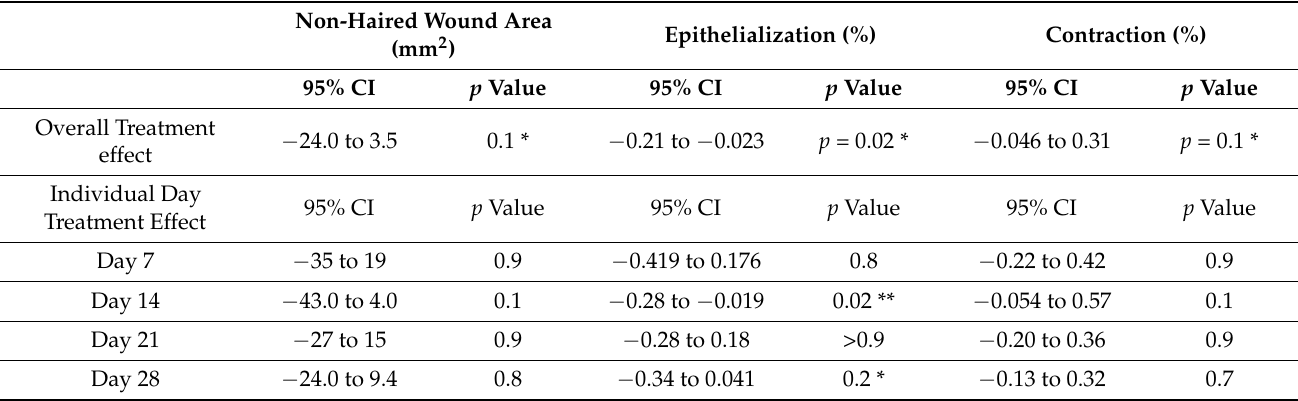
Table 3. GEE analysis of rate of limb wound closure by epithelialization and contraction following IV allo-CB-MSC administration.